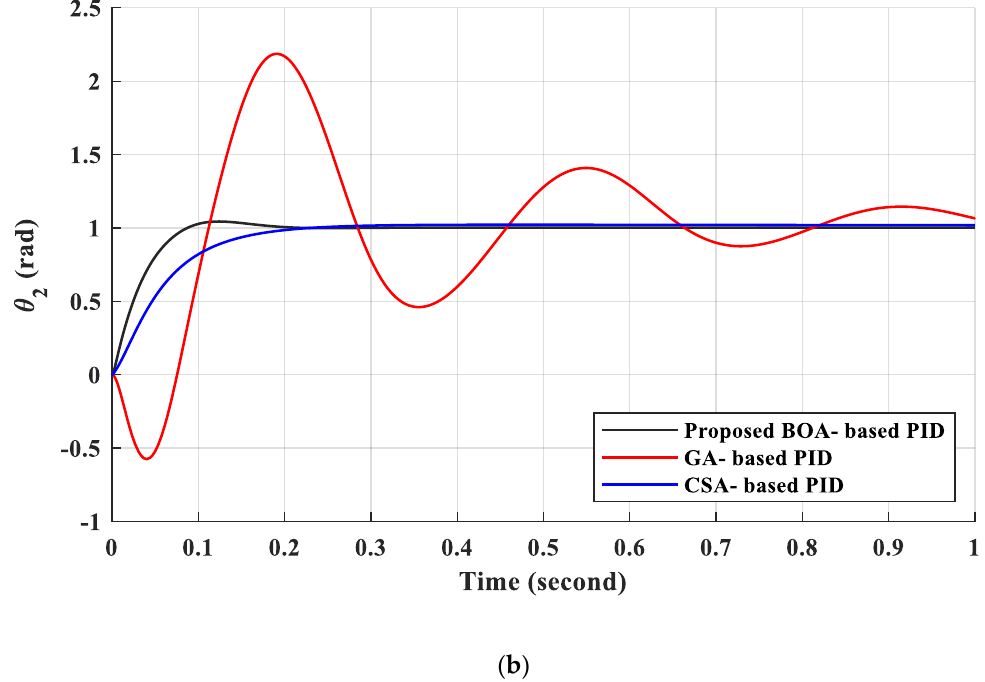
Figure 12. The output position of in case of increasing the parameters by +20% ( a ) the position of link 1 , ( b ) the position of link 2 .